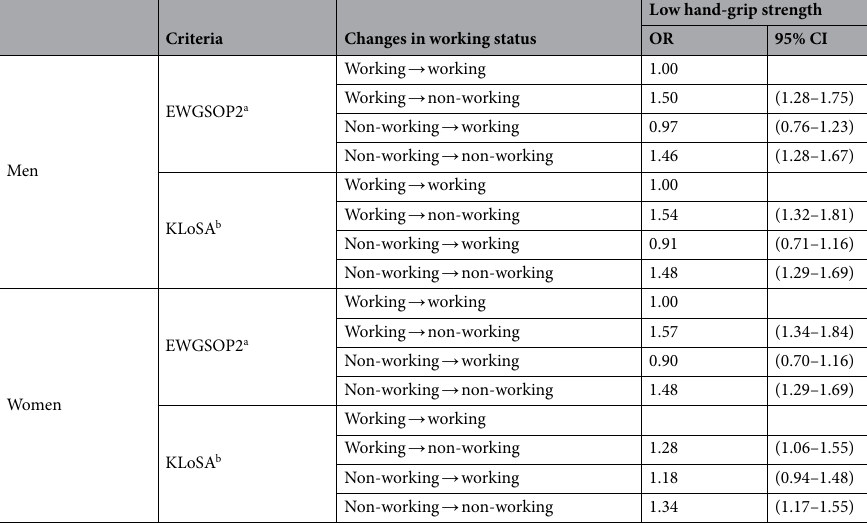
Table 3. Results of sensitivity analyses using GEE for association between changes in working status and hand-grip strength by different criteria for defining HGS. GEE Generalized estimating equation, OR odds ratio, CI confidence interval, EWGSOP2 European Working Group on Sarcopenia in Older People2, KLoSA Korean Longitudinal Study of Ageing. ORs were adjusted for other covariates, respectively. a The criteria for low hand- grip strength defined by EWGSOP2 were < 27 kg for men and < 16 kg for women. b The lower 25 percentiles of the KLoSA data were defined as the low hand-grip strength group, and the criteria were < 26.75 kg for men and < 16.25 for